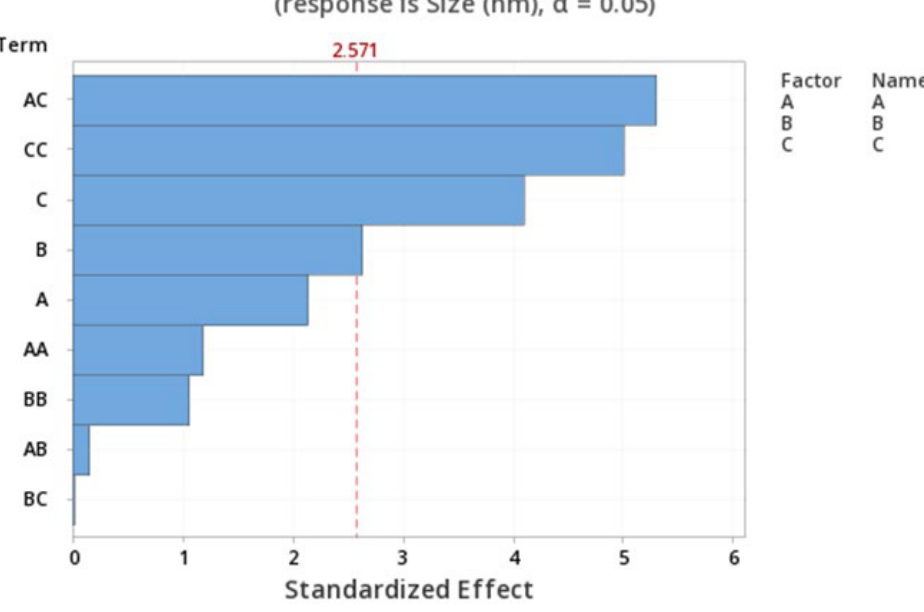
Figure 2. Pareto chart expressing the standardized effect of independent variables and their interac- tion on the size of the NPs.